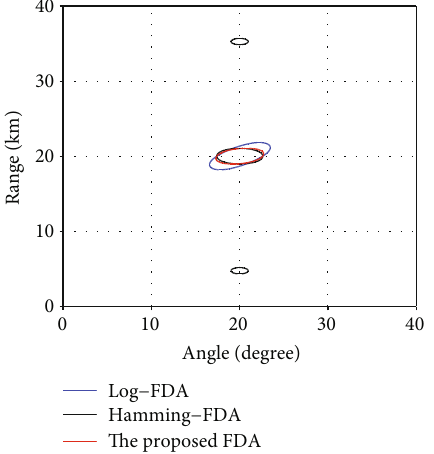
Figure 8: Half-power beam width comparison for the transmit- receive